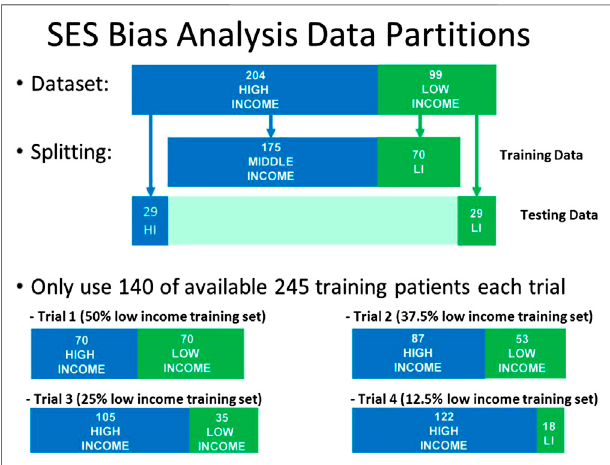
FIGURE 8 | Data partitions used for Socio-Economic (SES) bias analysis. The size of the test set and the size of the training set were kept constant, but the proportion of low-SES vs high-SES was varied in the training